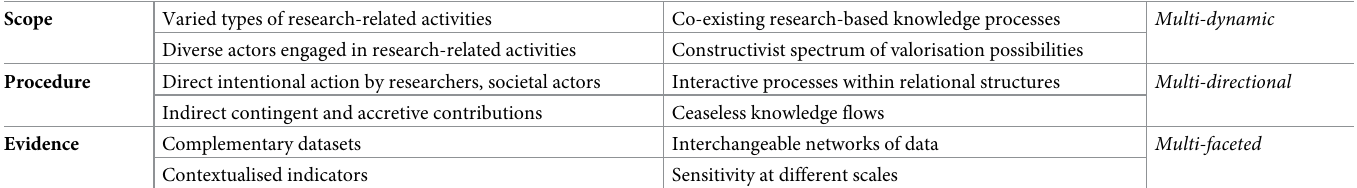
Table 1. Summary of the research-related knowledge processes approach to value creation.